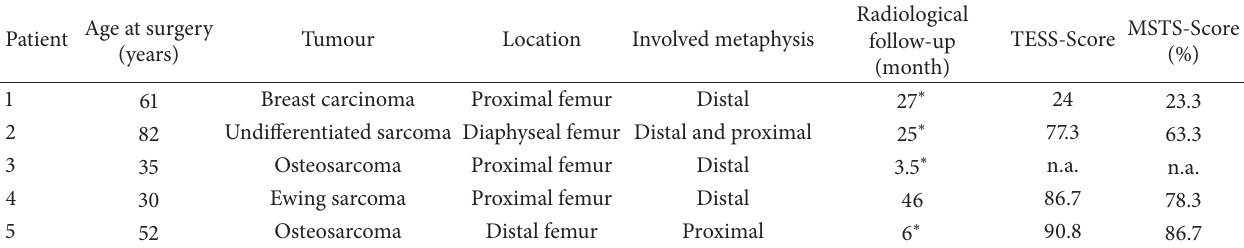
Table 1: Patient data and results of TESS- and MSTS-Scores ( ∗ death of patient, n.a. = not available). Age at surgery Patient